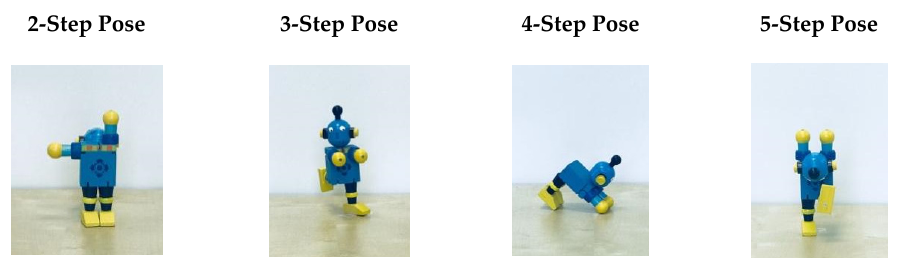
Figure 1. Final robot Poses for 2-, 3-, 4- and 5-Step Sequences.